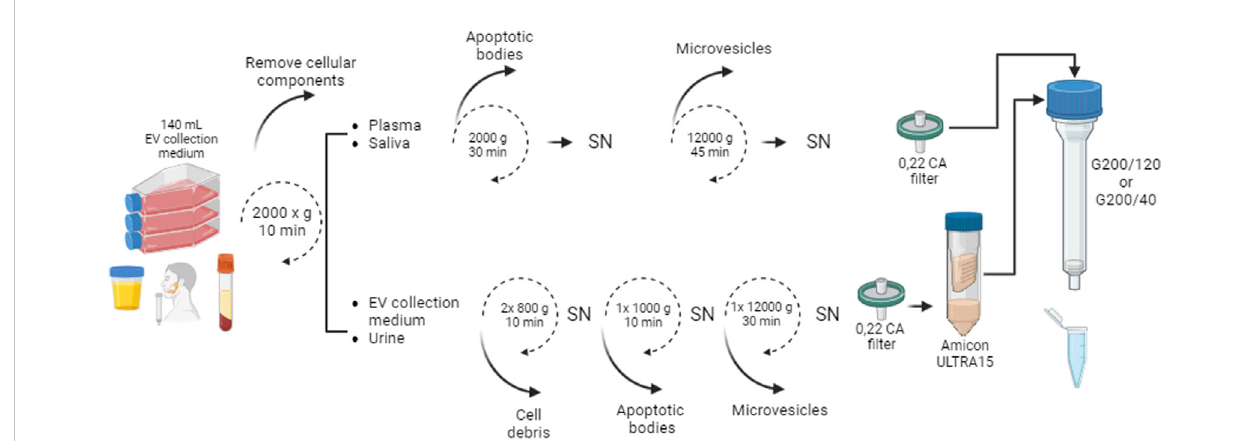
FIGURE 1 Schematic work fl ow for small EVs isolation by SEC. The samples were centrifuged and fi ltered. Only EV collection medium and urine samples were concentrated using Amicon Ultra-15 Centrifugal Filter Unit (Merck Millipore). Five hundred 500 µL of the pre-treated samples were loaded onto the column. Collected fractions were analyzed to determine protein content and EV number. SN: